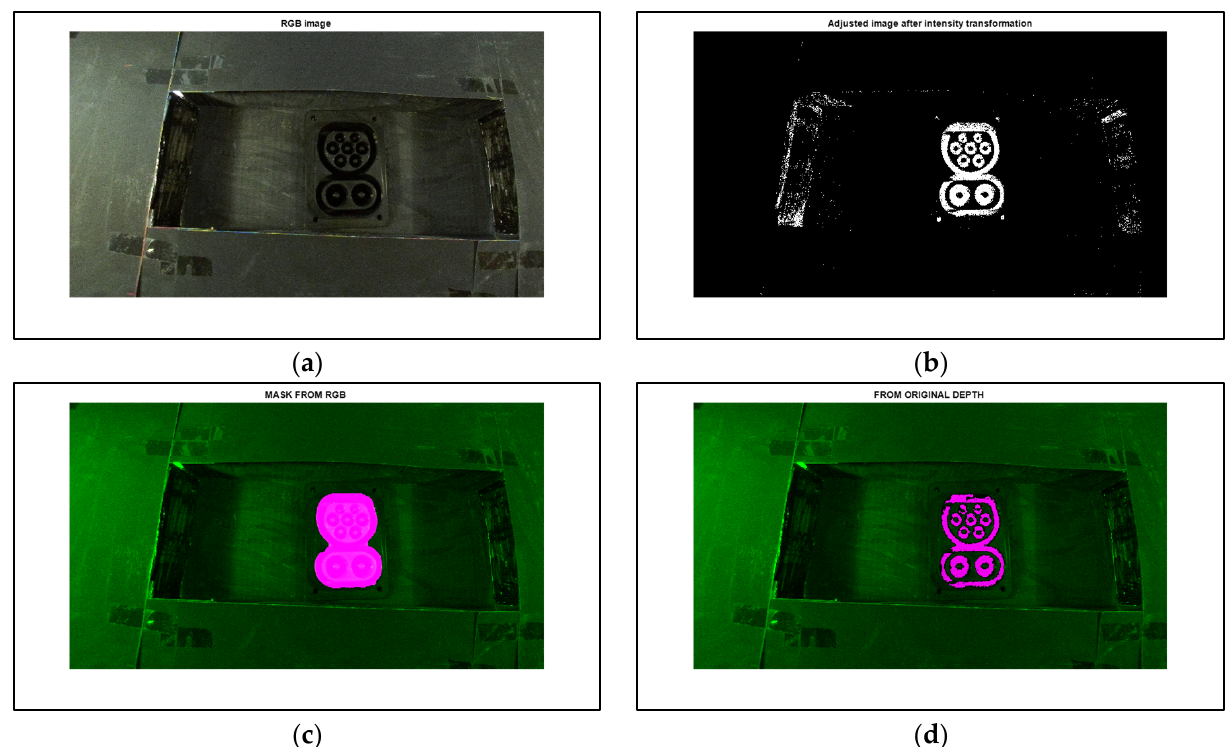
Figure 13. ( a ) Input RGB image, ( b ) result of the intensity transformation, ( c ) obtained binary mask, and ( d ) detected CCS2 connector.